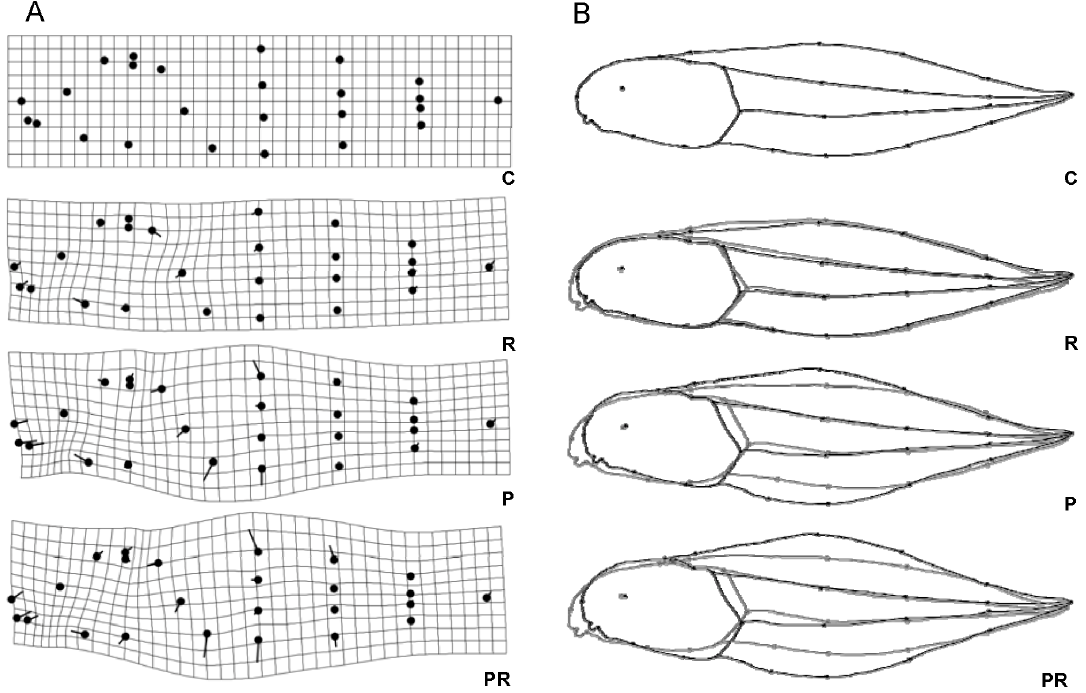
Figure 3. Transformation grids with landmarks and warped outline drawings for each treatment’s tadpole shape. a) Transformation grids with landmarks (black dots) and vectors showing direction of variation; b) comparison of warped outline drawings for each treatment shape (black) and control shape (grey). Transformation grids and warped outline drawings were magnified (x5) to better illustrate the differences. C – Control, R – Roundup, P – Predator and PR – Predator + Roundup.